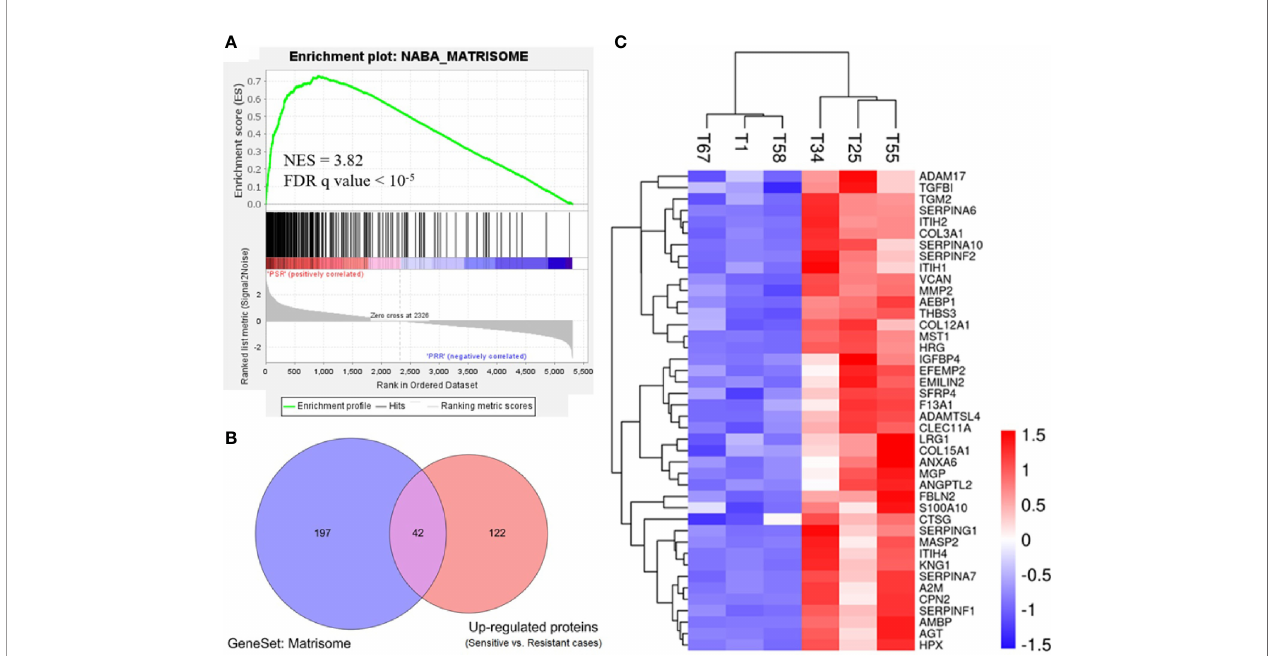
FIGURE 2 | Enriched expression of extracellular matrix-related proteins in the platinum-sensitive tumors. (A) Gene set enrichment analysis (GSEA) of a gene set for extracellular matrix-related proteins in the proteomic data. NES, normalized enrichment score; FDR, false discovery rate; PSR, platinum-sensitive recurrent high-grade serous ovarian cancer (HGSOC). PRR, platinum-resistant recurrent HGSOC. (B) Overlapping proteins of interest between the extracellular matrix gene cluster (matrisome) of 239 proteins and the upregulated proteins (platinum-sensitive tumors vs. platinum-resistant tumors). (C) Heatmap of Z-score normalized expression abundance values of the 42 overlapping proteins of interest hierarchically clustered with Euclidean distance matrix and complete linkage. Red, high abundance; and blue, low